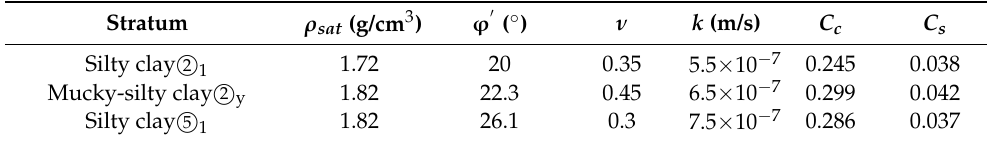
Table 1. Parameters of the soil layer.